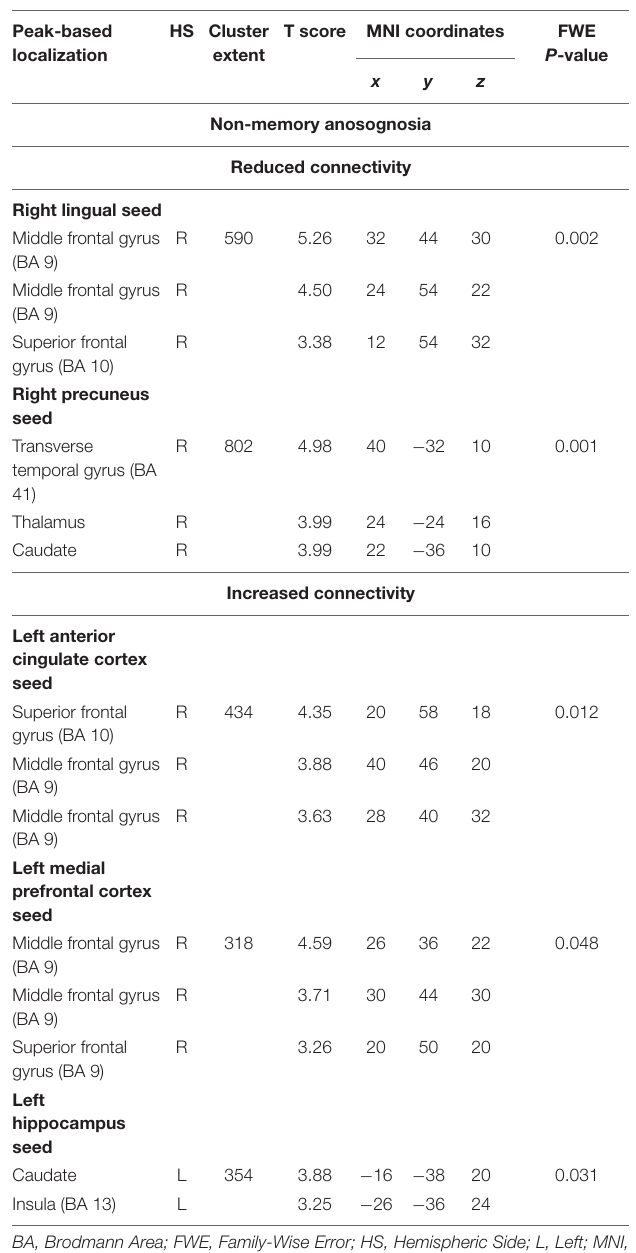
TABLE 4 | Neural correlates of non-memory anosognosia emerging from functional-connectivity patterns obtained via seed-based analysis. Peak-based HS Cluster T score MNI coordinates FWE localization extent